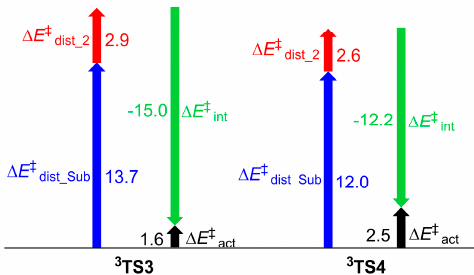
Figure 10. Distortion/interaction analysis of the two transition states in the hydrogen atom abstraction step. Energies are in kcal mol − 1 , and were obtained at the ONIOM(M06/def2 − TZVP:UFF //BPW91/6 − 31G* − LANL2DZ:UFF) level.